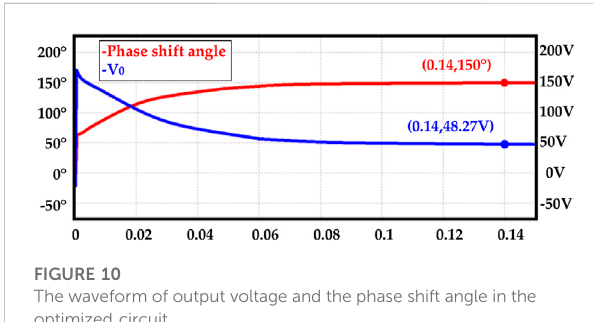
FIGURE 10 The waveform of output voltage and the phase shift angle in the optimized circuit.